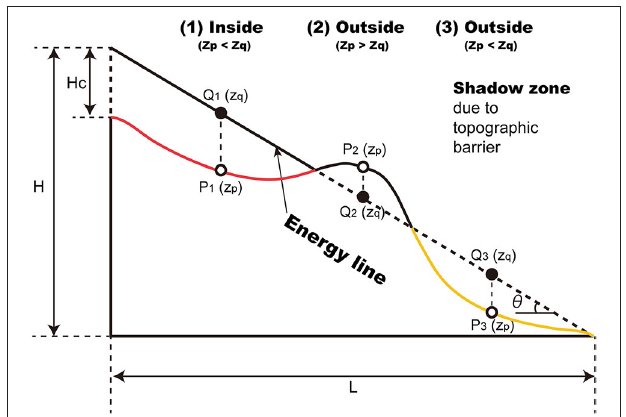
FIGURE 4 | Concept of Energy line model. Relative height (H), lateral travel distance (L) and Column collapse height (Hc) are shown. If the energy line position is higher than the topography, the area can be affected by volcanic gravity flows (case 1). If the energy line position is lower than the topography, the area is assumed not to be affected by volcanic gravity flows (case 2). The shadow zone, where the lee side of the topographic barrier is located and the energy line is higher than the topography, can be evaluated using VHASS (case 3).